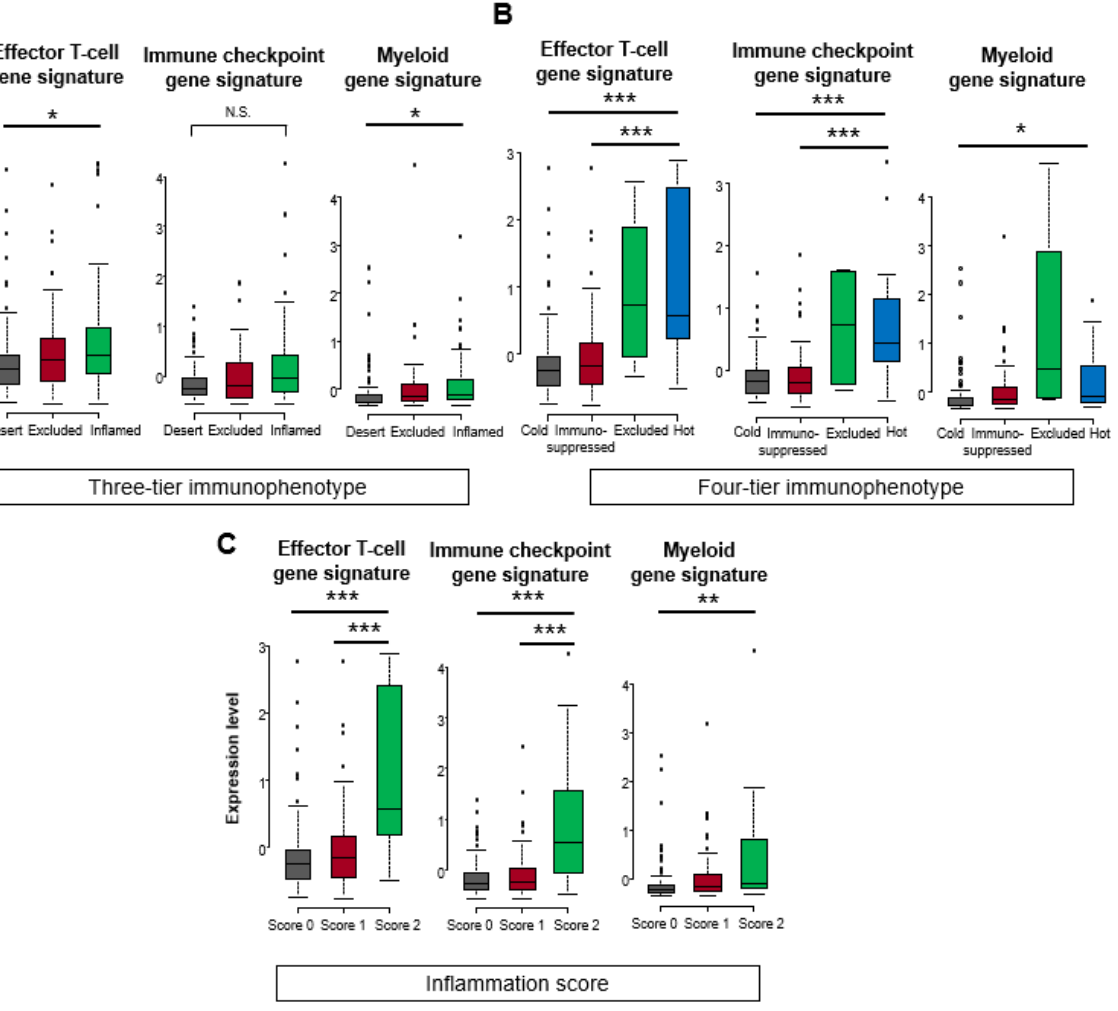
Figure 4. Comparison of gene expression signatures among three-tier and four-tier immunophenotype and inflammation score in the TCGA cohort. Comparison scores (mean Z-score) related to effector T-cell, immune checkpoint, and myeloid among ( A ) three-tier immunophenotype, ( B ) four-tier immunophenotype, and ( C ) inflammation score. Kruskal–Wallis test was used for statistical analysis (N.S. means not statistically significant. * p < 0.05, ** p < 0.01, *** p < 0.001 assessed by Mann–Whitney U-test).